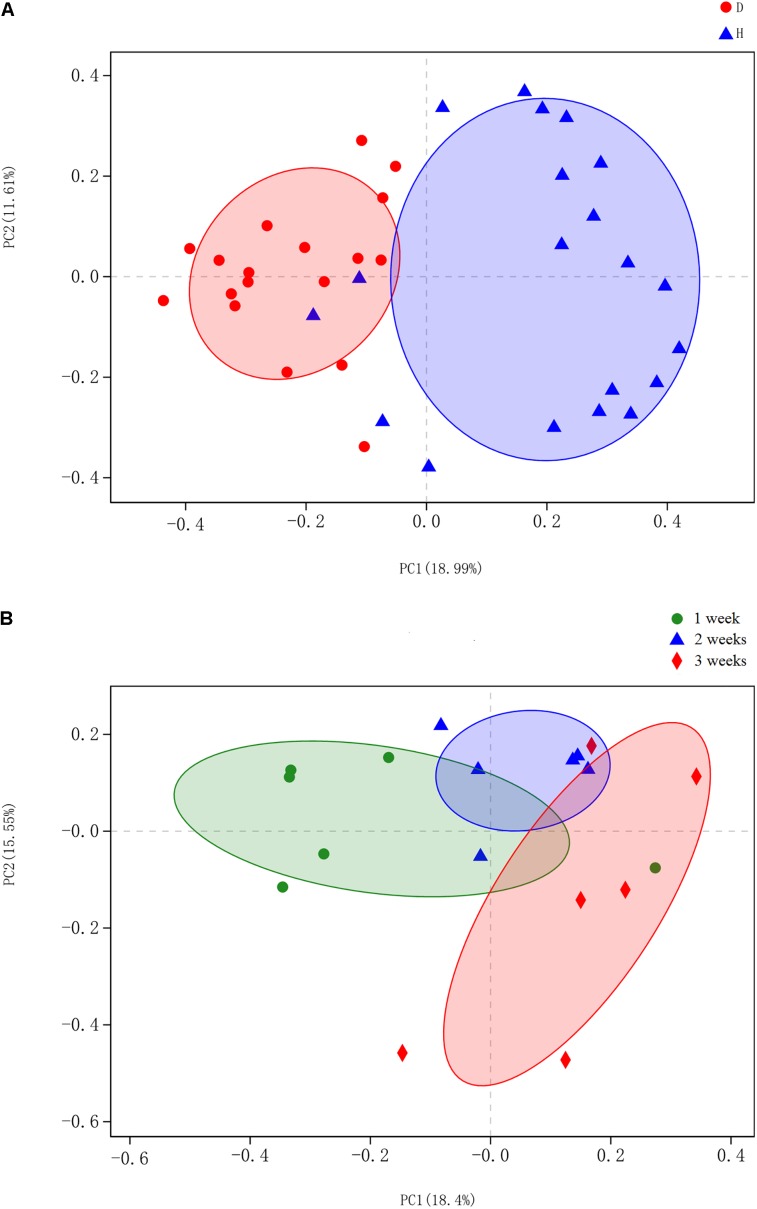
Principal coordinates analysis (PCoA) was performed at the operational taxonomic unit (OTU) level based on unweighted UniFrac distance for all samples. Each group is represented in a different color and shape. (A) Scatterplot from PCoA showed a clear separation of diarrheal (D) from healthy (H) samples (p < 0.05, analysis of similarity (ANOSIM)); Principal coordinates 1 and 2 (PC1 and PC2) represent 18.99 and 11.61% of the variance, respectively (x and y axes). (B) PCoA scatterplot identified significant bacteria compositional difference among the three ages (p < 0.05, ANOSIM). Principal coordinates 1 and 2 (PC1 and PC2) represent 18.4 and 15.55% of the variance, respectively (x and y axes).